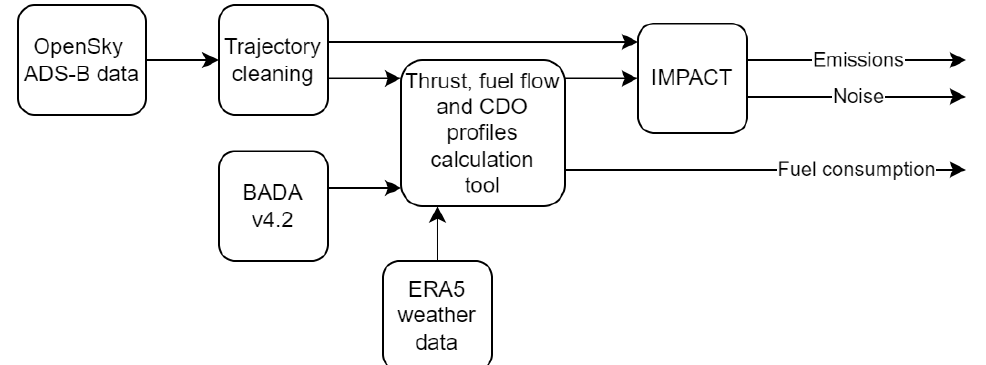
Figure 2. Flow chart overview of the different databases and models used for the calculations of fuel consumption, emissions and